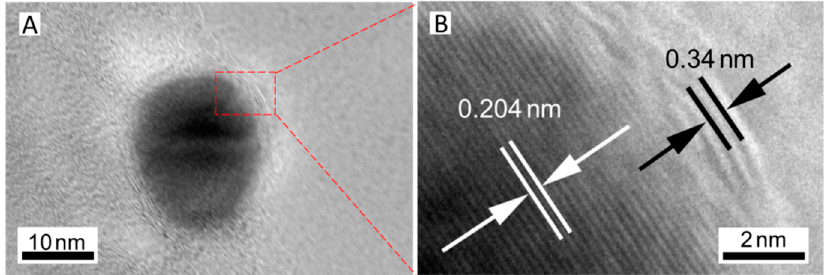
Figure 3. ( A ) transmission electron microscope (TEM) image and ( B ) high resolution transmission electron microscope (HRTEM) image of Co@N-C-800. electron microscope (HRTEM) image of